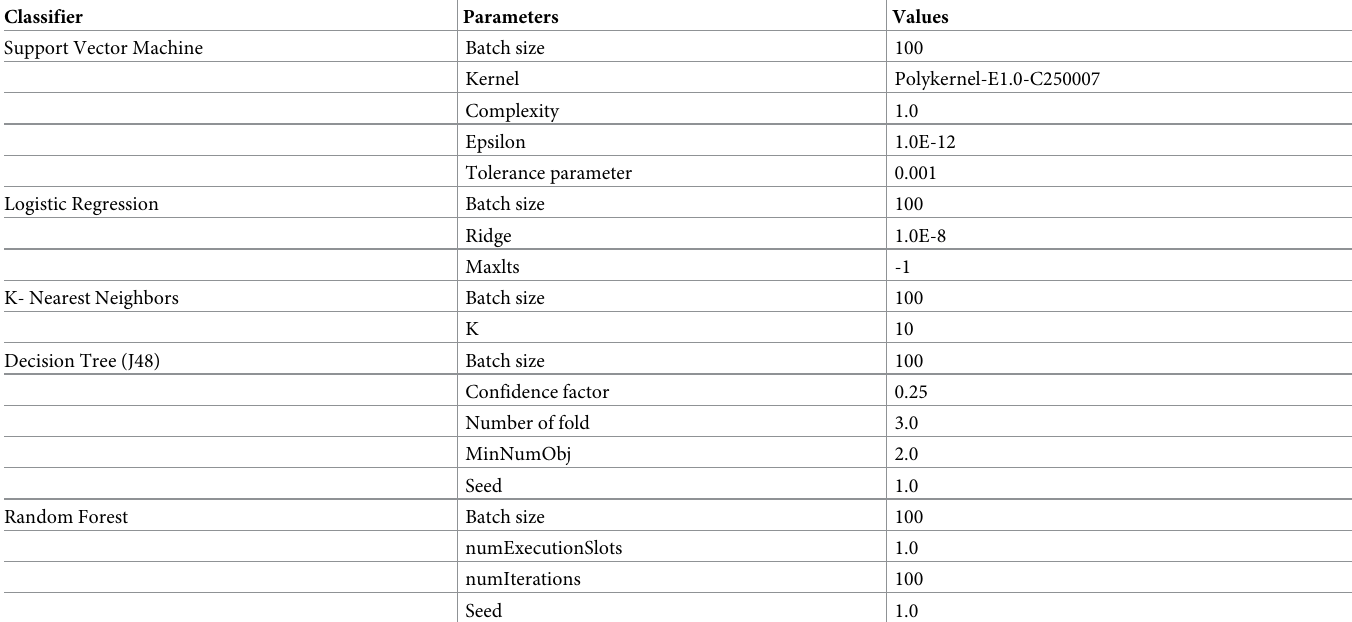
Table 6. Parameter optimization and tuning values of classifiers.